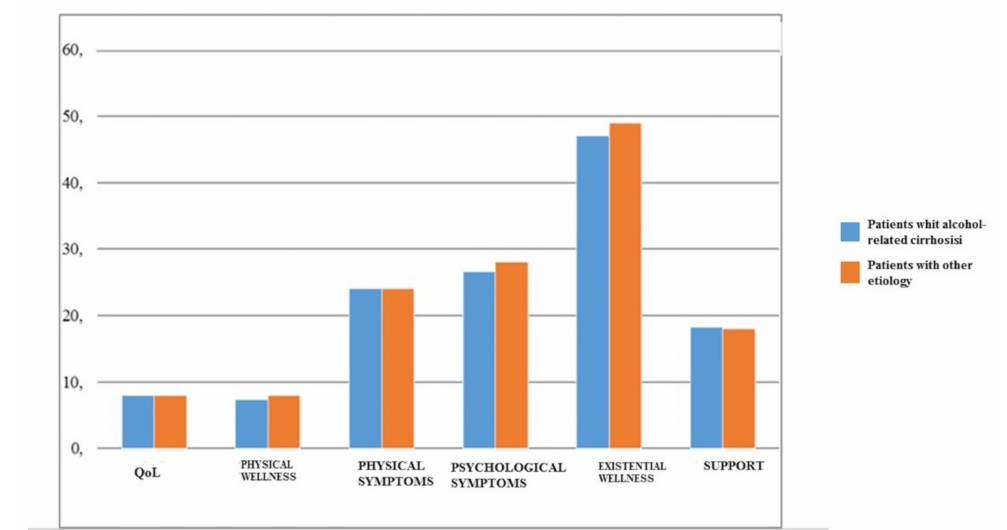
Figure 3. Comparison between patients transplanted for alcohol-related cirrhosis and patients with 173 other